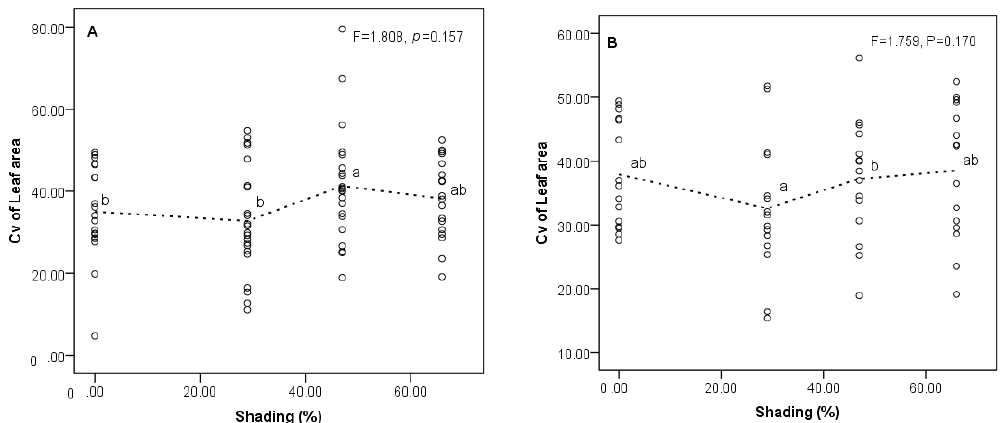
Figure 4. The distribution of variation coefficients of leaf traits in different populations at different shading gradients. Each circle presents a value for a different species, and the dotted line presents the changes in the mean of the overall species. All species that were studied in the communities ( A ) and the same species in the four treatments ( B ) were analyzed. Different letters indicate significant differences among the four shading treatments.